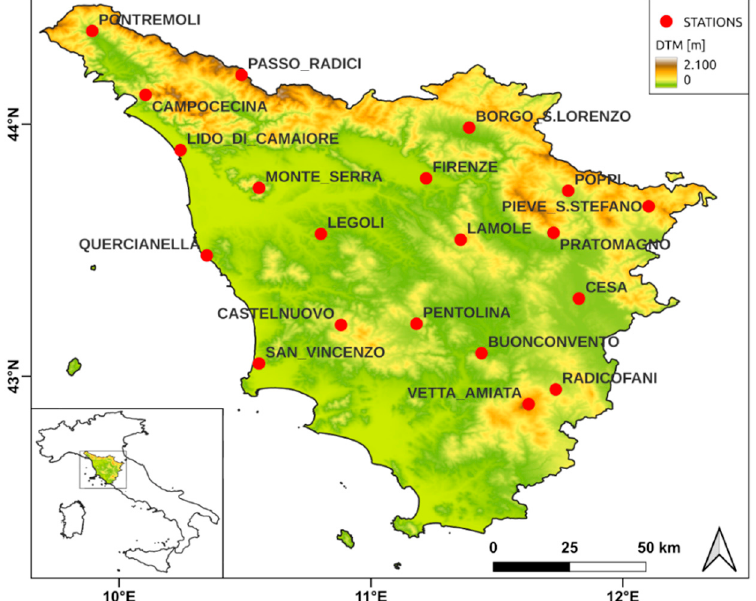
Figure 1. Digital elevation model of the study region (Tuscany) with position of the 20 weather stations considered (red dots). The lower left box shows the position of Tuscany in Italy.